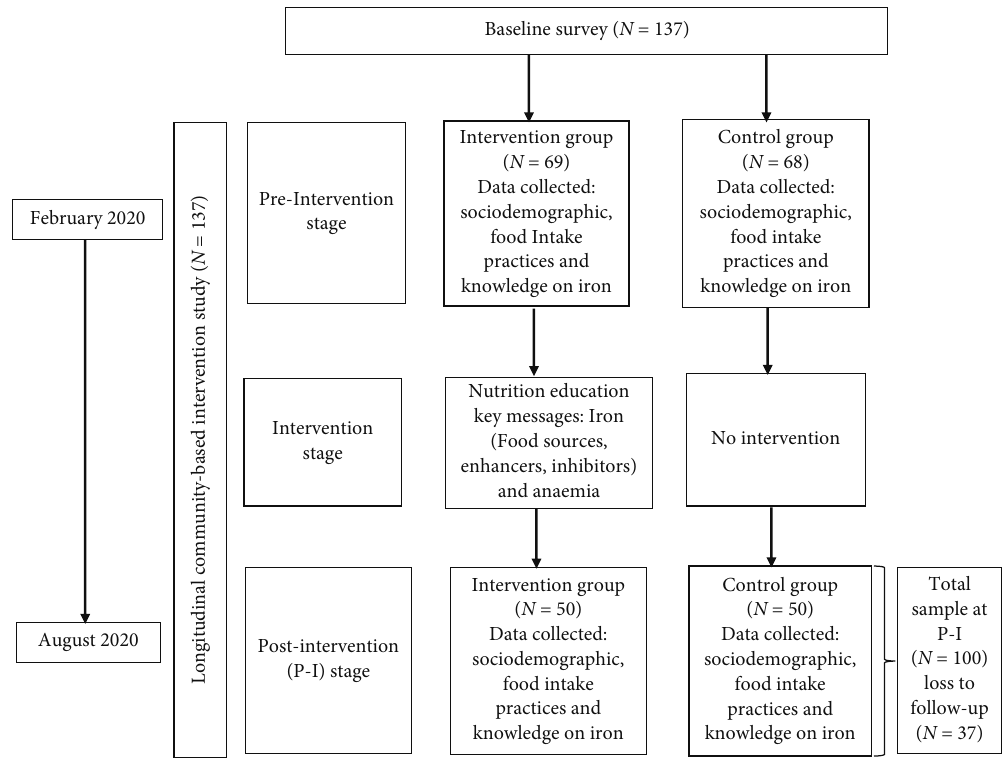
Figure 1: Overview of the Table 1: Lesson plan for nutrition education.